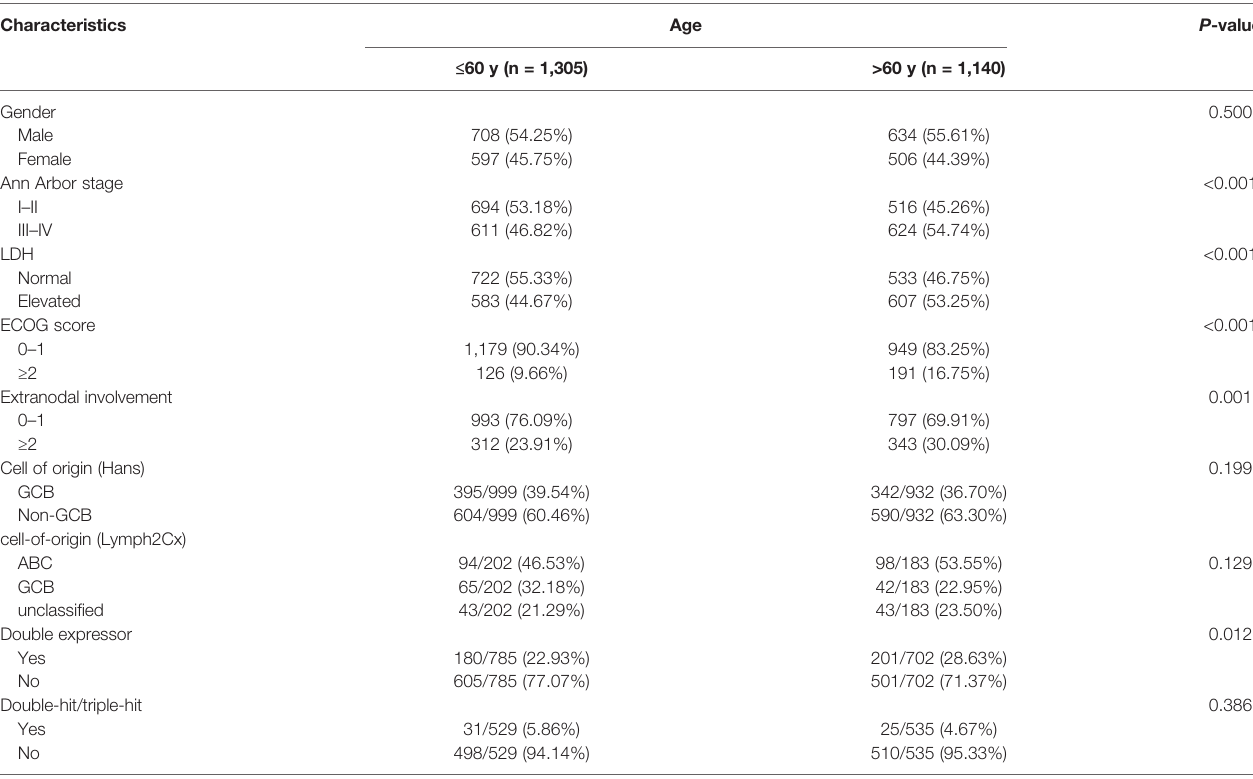
TABLE 1 | Clinical and pathological characteristics of DLBCL patients (n =